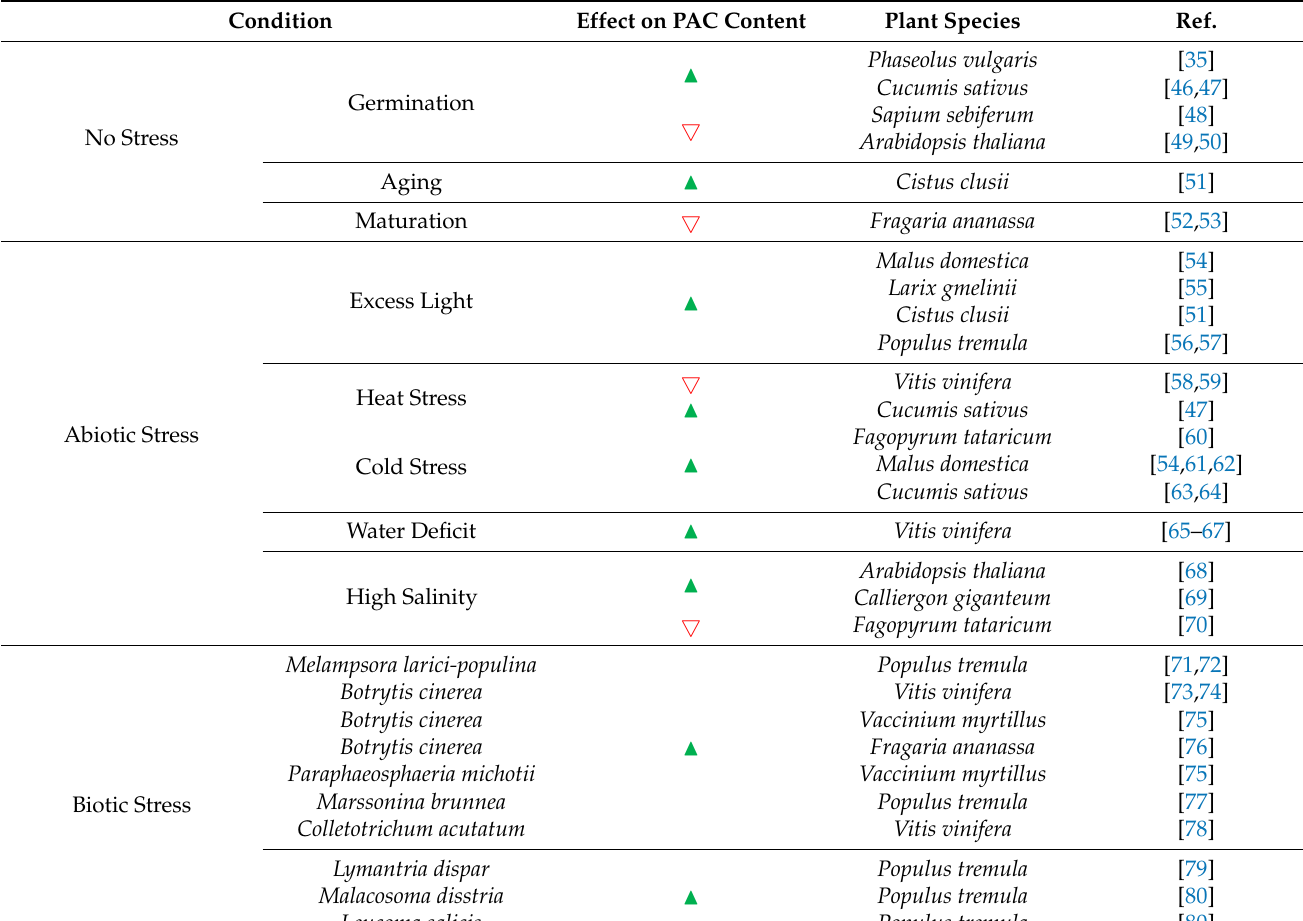
Table 1. Documentedplantphysiologicalprocessesandplantresponsestoabioticandbioticstressesthatinvolveproanthocyanidins.